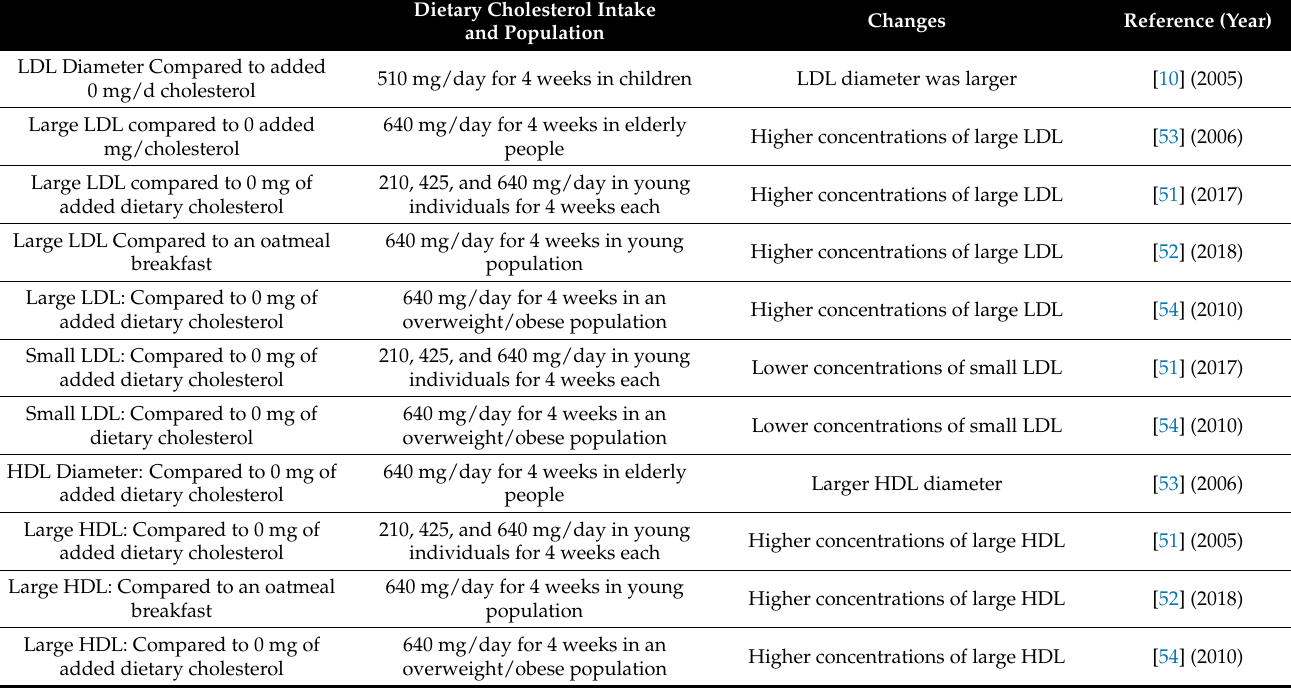
Table 2. Beneficial Modifications in LDL and HDL size and subfractions due to dietary